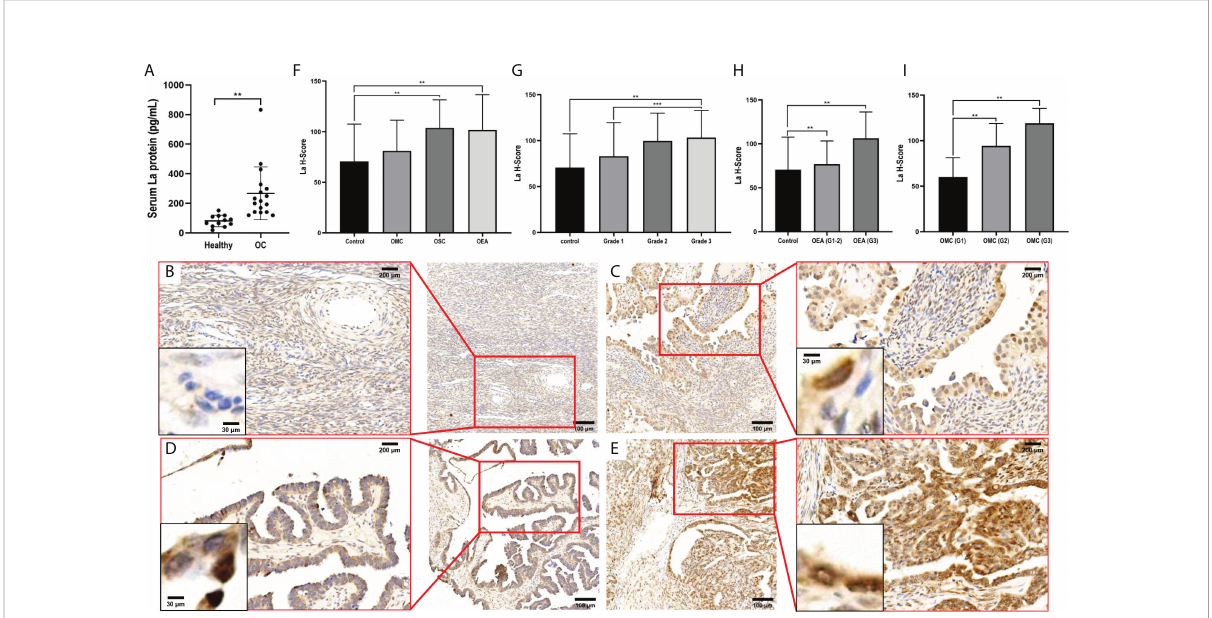
FIGURE 1 Expressions of La protein in ovarian cancer. (A) The expression of La protein in serum of healthy volunteers and patients with ovarian cancer. Typical images of La protein expression in different types of ovarian tissues: normal ovarian tissue (B) , ovarian serous cystadenocarcinoma tissue (C) , ovarian mucinous cystadenocarcinoma tissue (D) , and ovarian endometrioid adenocarcinoma tissue (E) . The expression of La protein in ovarian cancer (F) and its relationship with the pathological grade of ovarian cancer (G) . (H) The expression of La protein in ovarian endometrioid adenocarcinoma. (I) The expression of La protein in ovarian serous cystadenocarcinoma. The statistical methods were t-test and t-test one-way ANOVA. All data were expressed as mean ± SD (** P < 0.05, *** P < 0.01). OC, ovarian cancer; OEA, ovarian endometrioid adenocarcinoma; OMC, ovarian mucinous cystadenocarcinoma; OSC, ovarian serous cystadenocarcinoma